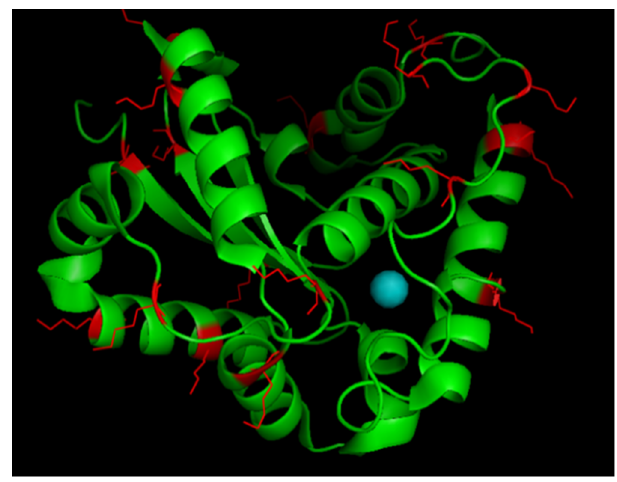
Figure 4. Determination of the optimal NP:r Vu FeSOD ratio: Lines (1) Citrate AuNPs, (2) 1:1 Citrate AuNP:r Vu FeSOD, (3) 1:10 Citrate AuNP:r Vu FeSOD, (4) 1:100 Citrate AuNP:r Vu FeSOD, (5) 1:500 Citrate AuNP:r Vu FeSOD, and (6) 1:1,000 Citrate AuNP:r Vu FeSOD. The lowest amount of protein that maintained a stable colloidal solution after addition of NaCl was selected, corresponding to 1:500 AuNP:r Vu FeSOD (tube #5).